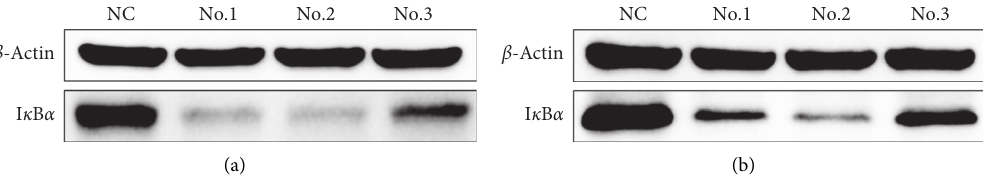
Figure 4: Western blotting for detection of I κ B α protein expression after NC-siRNA and three pairs of I κ B α -siRNA were transfected into CM cells and TM cells, respectively, at 10nM. (a) The relative protein expression of I κ B α of No.1, No. 2, and No. 3 groups were significantly lower compared to that of the NC-siRNA group in CM cells. The three pairs of I κ B α -siRNA could all inhibit the I κ B α protein expression, and the inhibitory rate of No. 2 was higher than that of the other two pairs. (b) The relative protein expression of I κ B α of No. 1, No. 2, and No. 3 group was significantly lower compared to that of the NC-siRNA group in TMcells. The three pairs of I κ B α -siRNA could all inhibit the I κ B α protein expression, and the inhibitory rate of No. 2 was higher than that of the other two